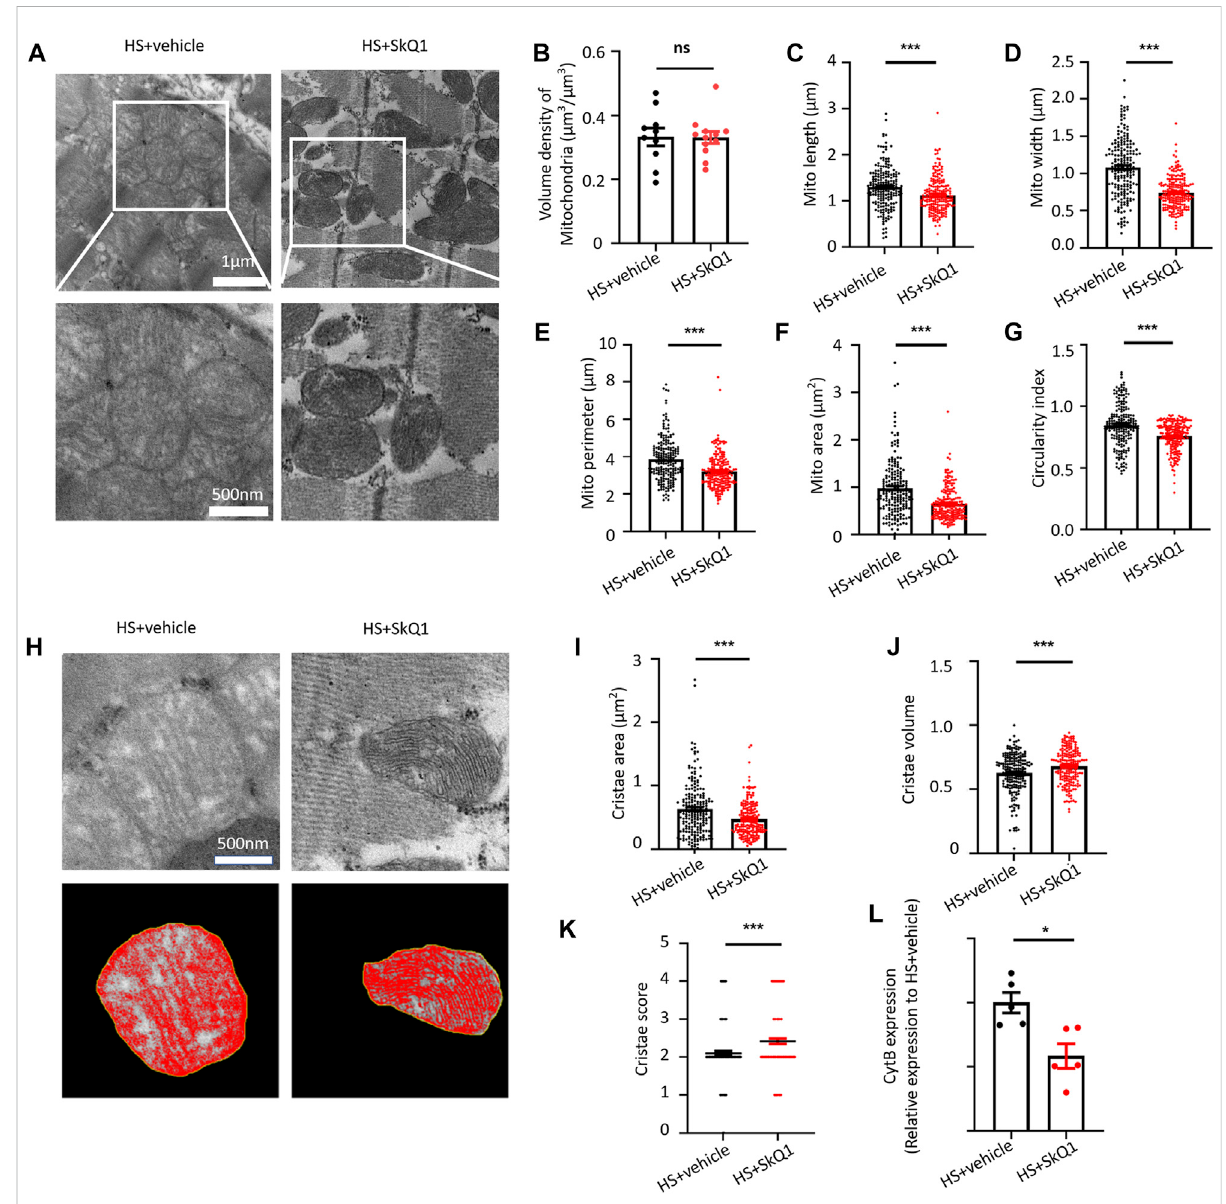
FIGURE 4 SkQ1 protects the ultrastructure of myocardial mitochondria and attenuates mtDNA release after HS. (A) Representative TEM images of mitochondria of the rat myocardial tissues from the HS + vehicleand HS+ SkQ1 group rats. (B – G) Statistical results of the myocardial mitochondrial volume density, length, width, perimeter, area, and circularity index in the HS + vehicle and HS + SkQ1 group, n = 200 mitochondria from 5 rats per group, *** p < 0.001 compared with the HS + vehicle group. (H) Representative TEM images of myocardial mitochondrial cristae ultrastructure of the HS + vehicle and HS + SkQ1 group. (I – K) Statistical results of the mitochondrial cristae area, cristae volume, and cristae score, n = 188 – 200 mitochondria from 5 rats per group, *** p < 0.001 compared with the HS + vehicle group. (L) Statistical results of the mitochondrial DNA CytB content in peripheral blood of the HS + vehicle and HS + SkQ1 group. n = 5 rats per group, * p < 0.05 compared with the sham